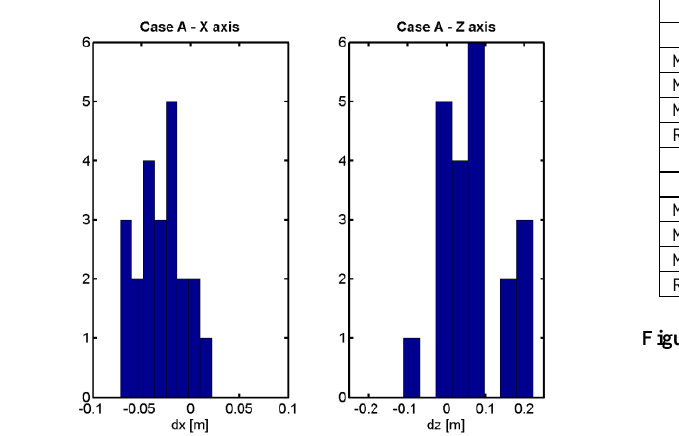
Figure 1. Case A: Histogram of residuals on the 22 check points